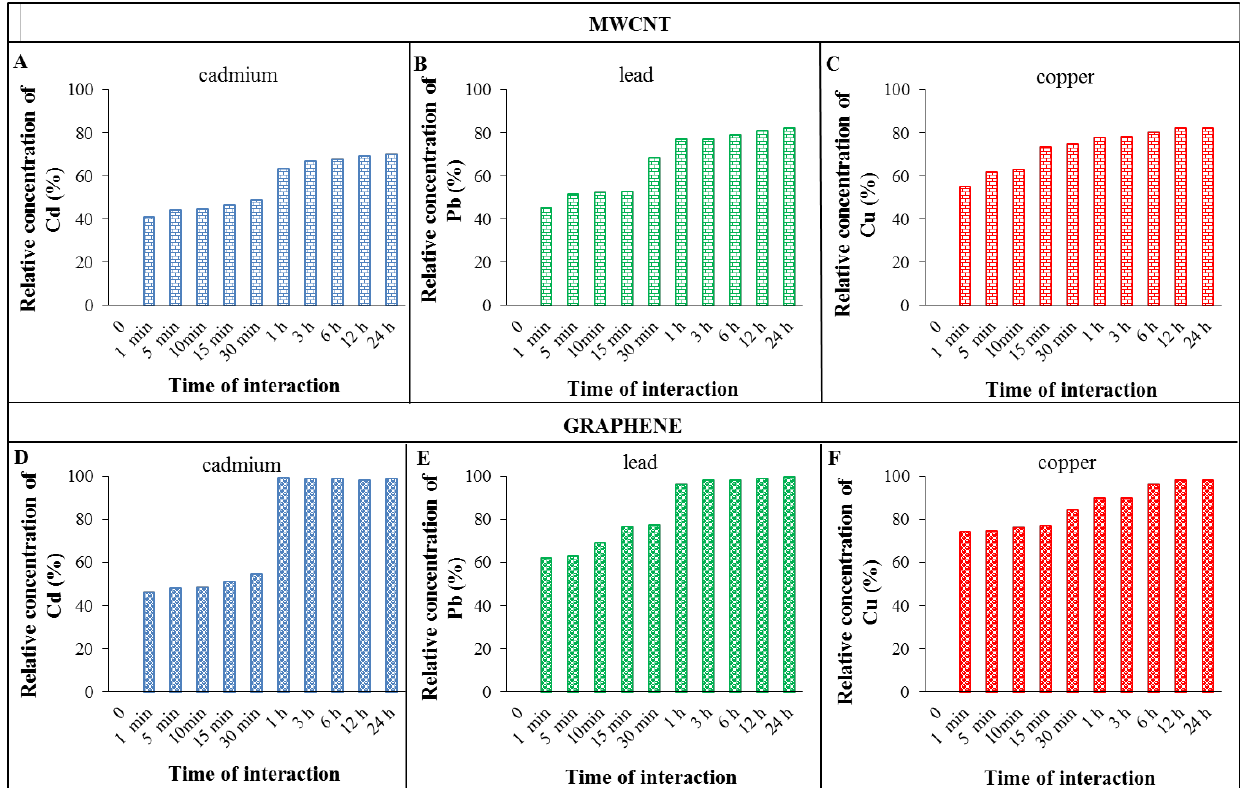
Figure 3. The amount of bounded cadmium ( A , D ); lead ( B , E ) and copper ( C , F ), on various adsorbents: ( A , B , C ) for multiwall nanotubes; ( D , E , F ) for reduced graphene oxide. All values were related to the applied concentration of metal (100 µM for cadmium, lead and copper). Zero on the x-axis is